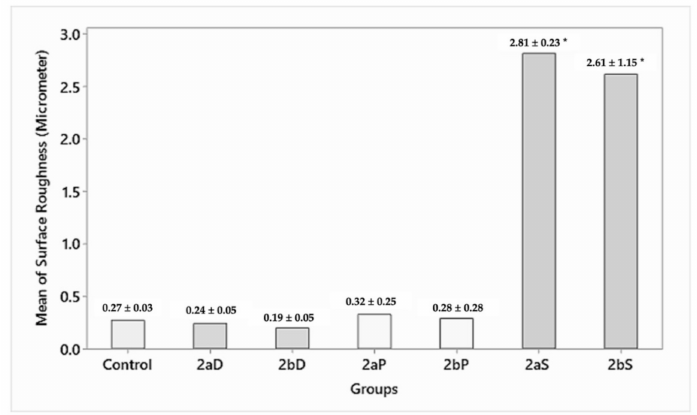
Figure 8. Surface roughness after polishing procedures (microns). * Annotates significant